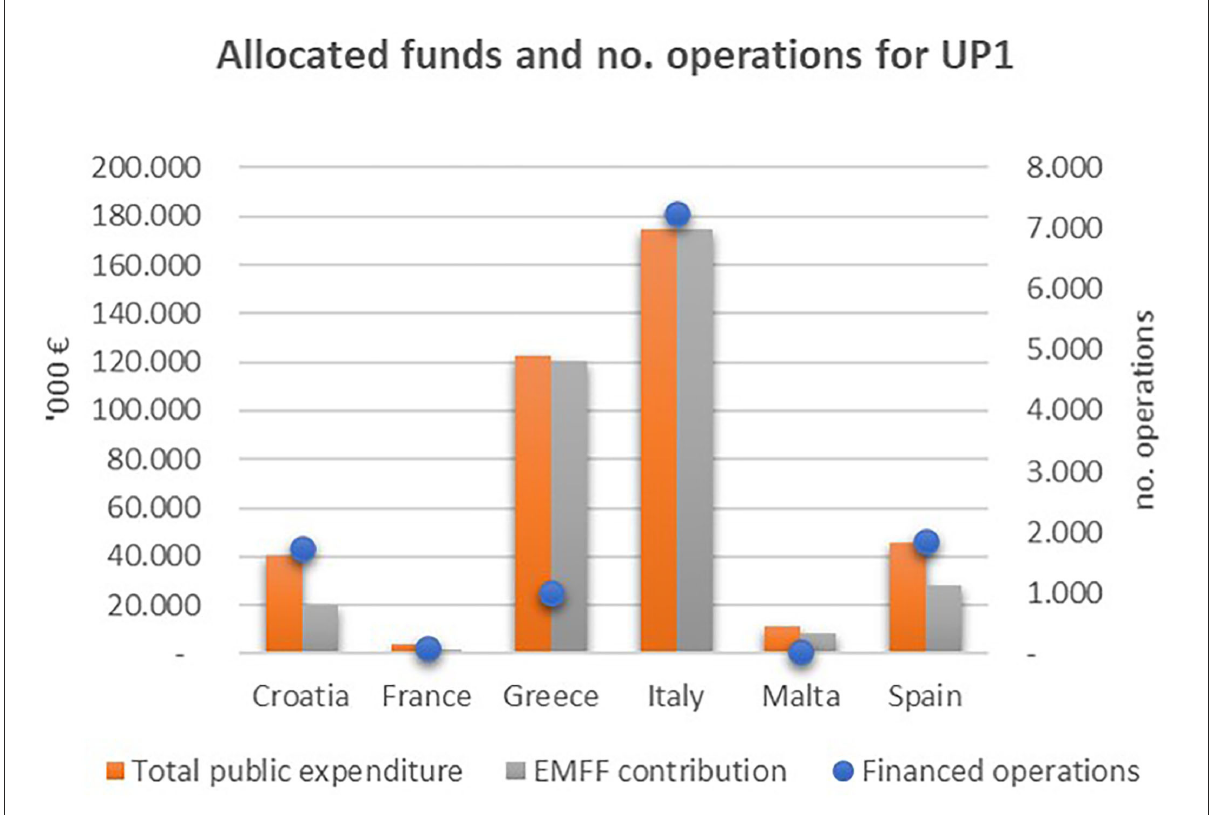
FIGURE11 Public expenditure, public contribution and number of operations allocated to the UP1 – (promoting environmentally sustainable, resource-efficient, innovative, competitive and knowledge-based fisheries) by MSs. Elaboration on data from the EMFF List of